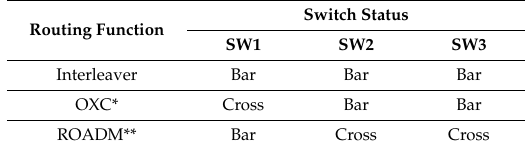
Table 2. Optical switch statuses of the proposed optical routing